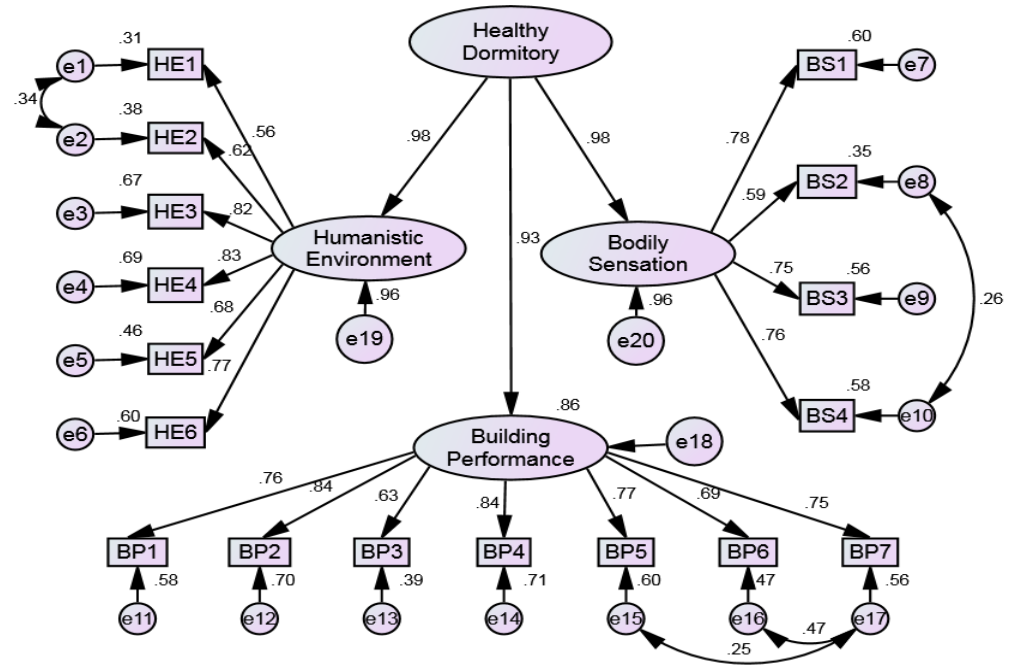
Figure 7. Standardized estimation of the second-order confirmatory factor analysis.